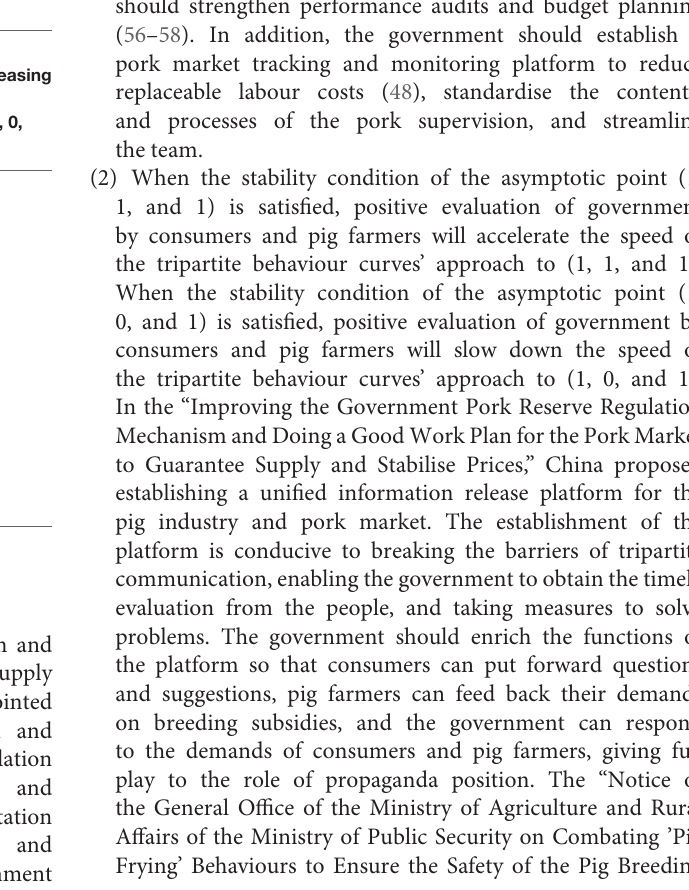
FIGURE 6 | Evolutionary simulation results of the parameter xyz . (A–C) is a three-dimensional comparison diagram of the three-way behavior selection under the condition of (1, 1, and 1) and the change of (x, y, and z) values. (D–F) is a three-dimensional comparison diagram of the three-way behavior selection under the condition of (1, 0, and 1) and the change of (x, y, and z) values. TABLE 5 | Influence of parameter increase on tripartite